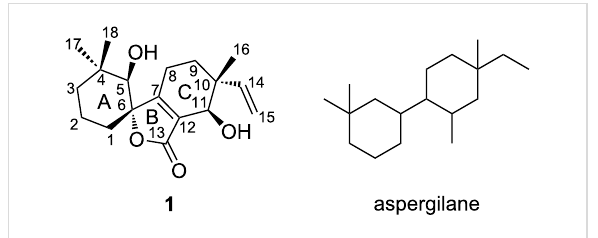
Figure 1: Structure of aspergiloid I ( 1 ) and its novel skeleton.